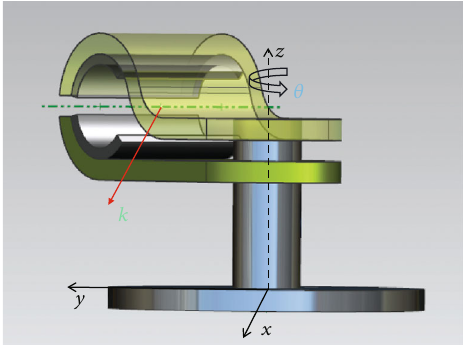
Figure 6: Calculation of clamp